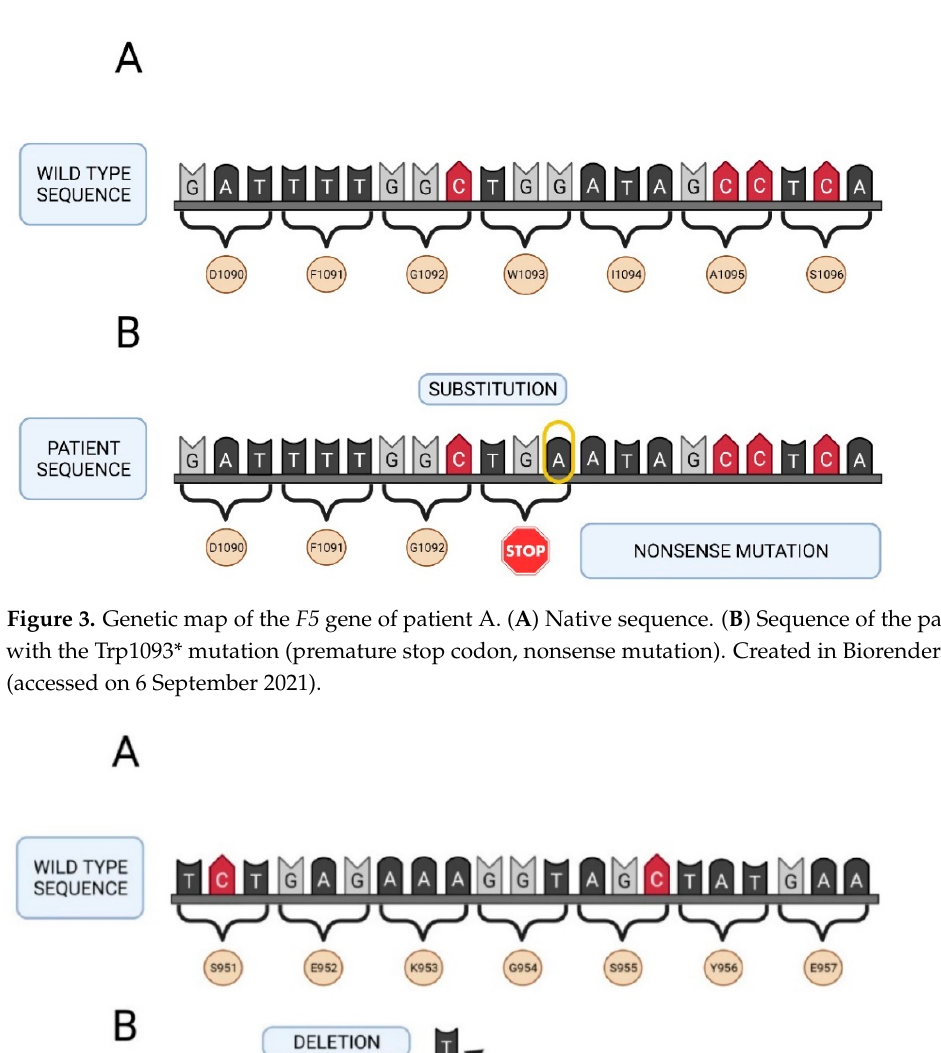
Figure 2. Genetic map of the F5 gene of patient A. ( A ) Native sequence. ( B ) Sequence of the patient with the Arg740* mutation (premature stop codon, nonsense mutation). Created in Biorender.com (accessed on 6 September 2021).